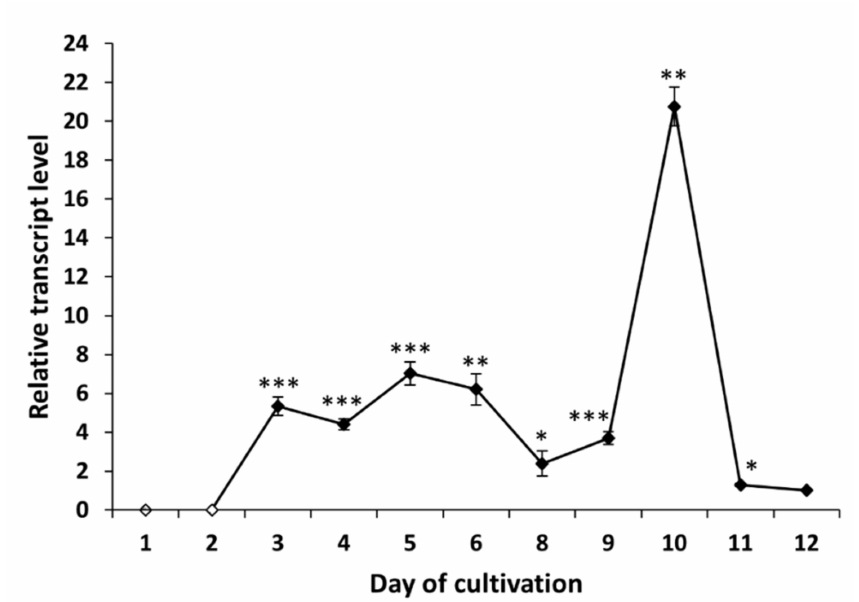
Figure 4. Expression profile of peptaibol synthetase tex1_Ta Trichoderma atroviride O1 cultivated in light–dark conditions (LD). White points indicate undetected tex1_Ta transcript. Reference (relative transcript level = 1) is the expression level detected on the 12th day of cultivation (12 d LD). Values with p < 0.001, 0.001 < p < 0.01, and 0.01 < p < 0.05 (compared to reference) are marked with ***, ** and *, respectively.